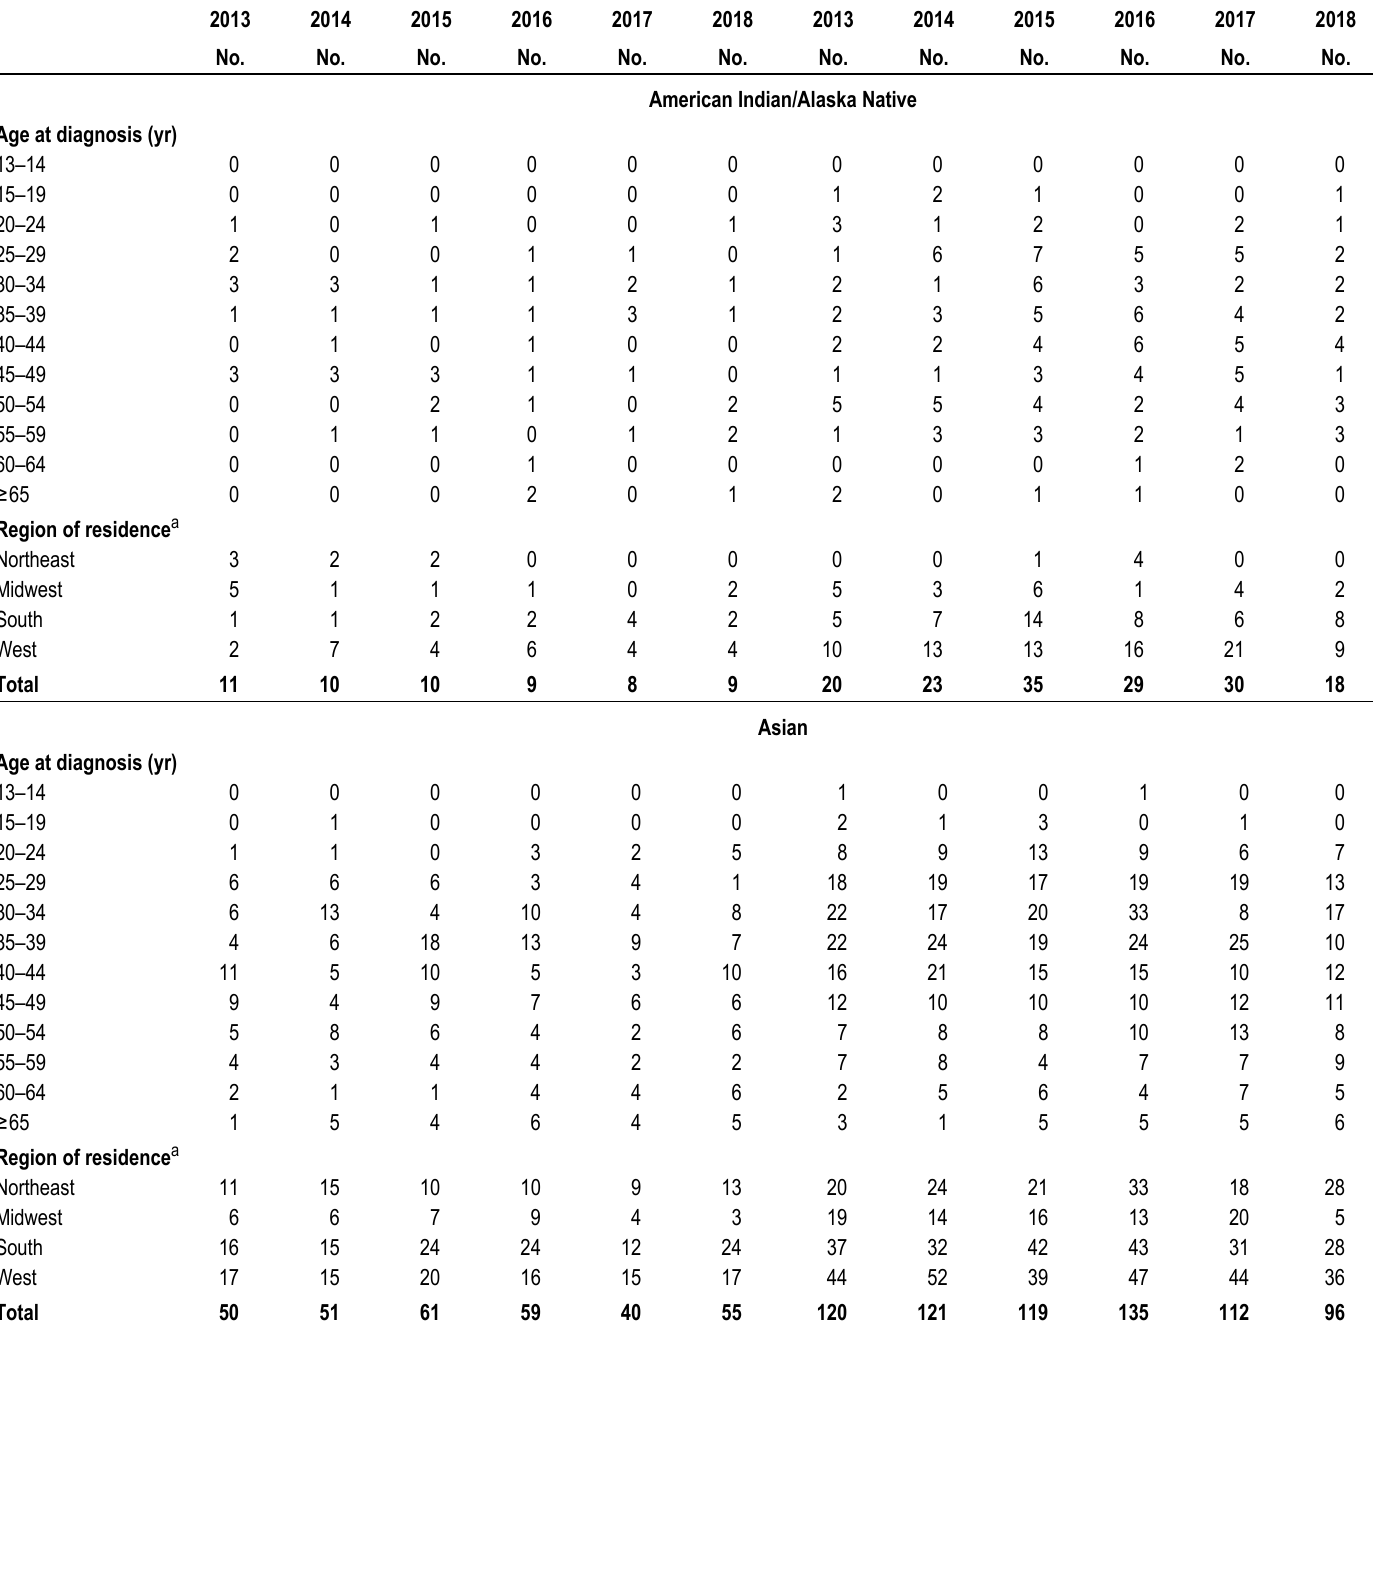
Table 9a. Diagnoses of HIV infection attributed to heterosexual contact, by selected characteristics, 2013–2018—United States